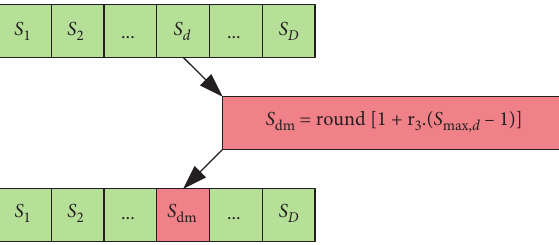
Figure 4: CGA mutation